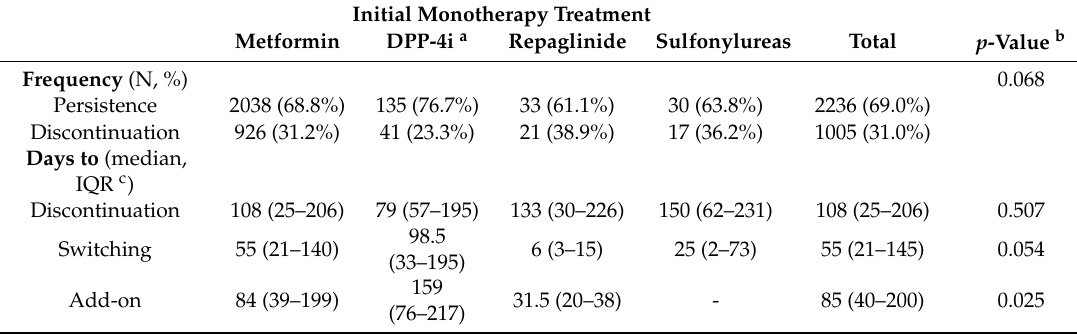
Table 3. Persistence and discontinuation among new users of antidiabetic drugs and time to discontinuation, treatment switching or add-on therapy, by initial monotherapy treatment (objectives ii and